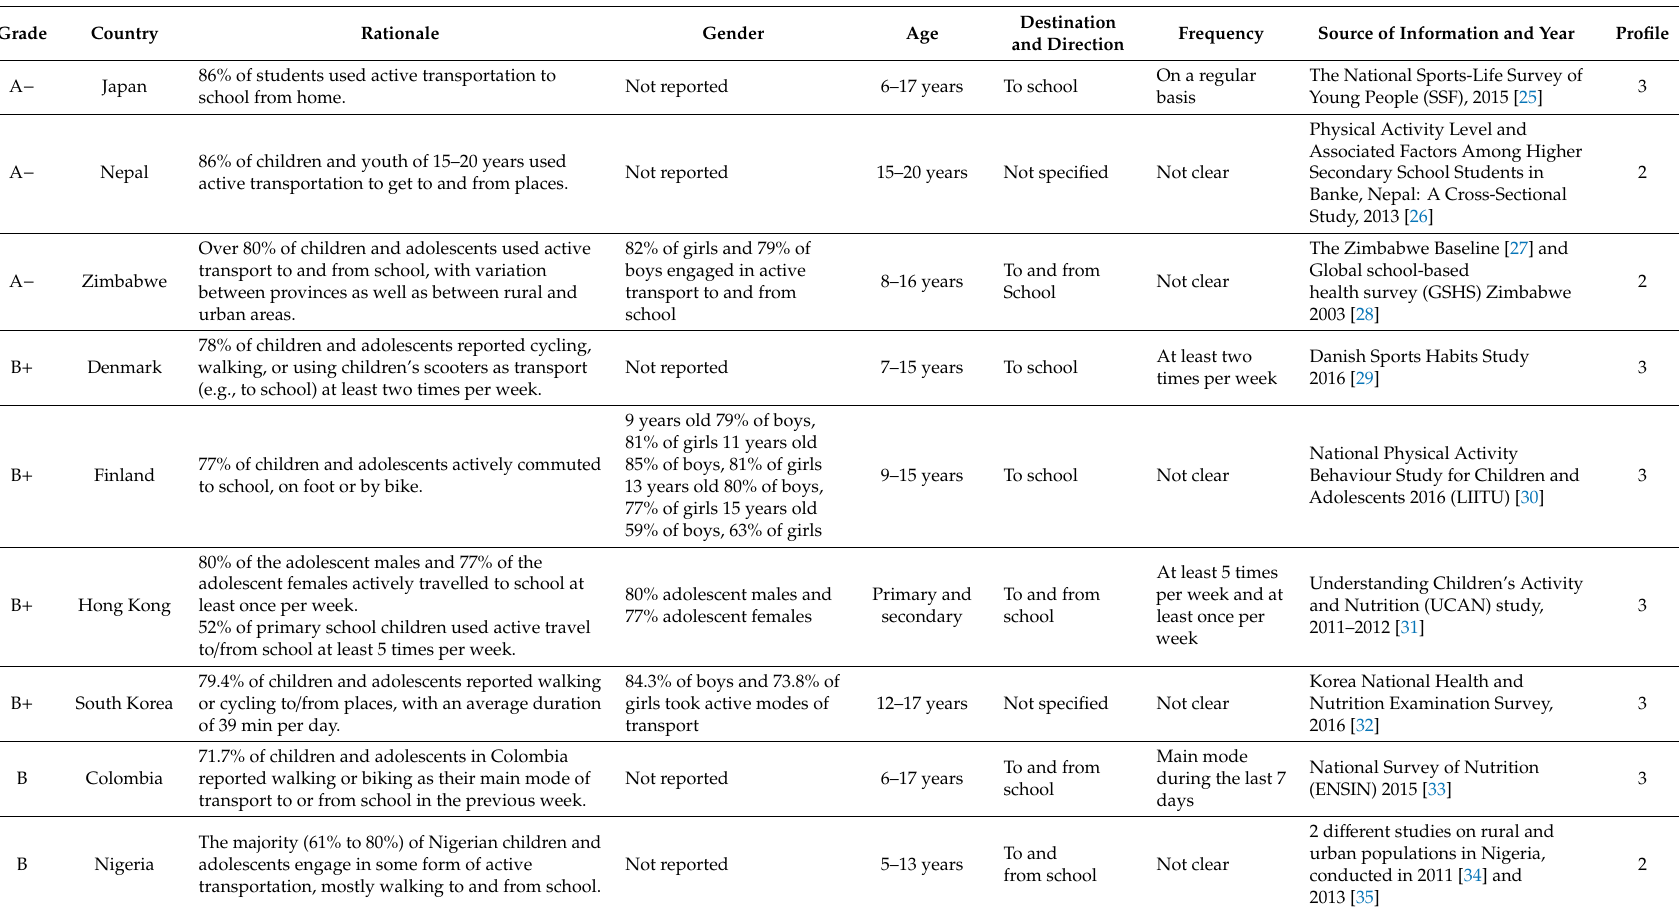
Table 3. Rationale for grades and information reported on active transportation by 49 countries involved in the Global Matrix